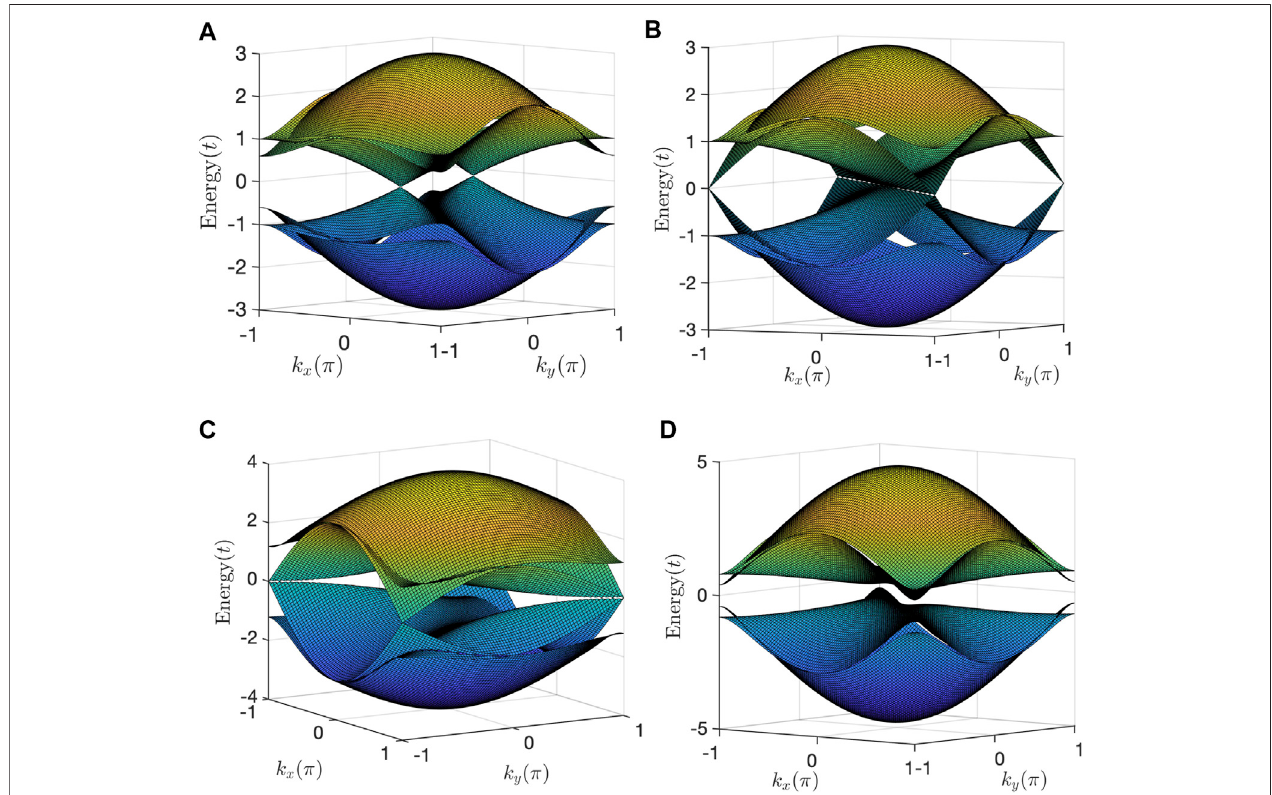
FIGURE2 | Bandstructure in different phases oftype-I 2D SSH model. (A) Band structure in the semimetallic phase with t x =0.2 t and t y = 0.8 t . (B) Band structure for the nodal-line metallic phase with t x = t y = 0.5 t . (C) Band structure for a critical phase point with t x = 1.6 t and t y = 0.4 t . (D) Band structure for the weak topological insulators with t x = 1.6 t and t y = 1.2 t